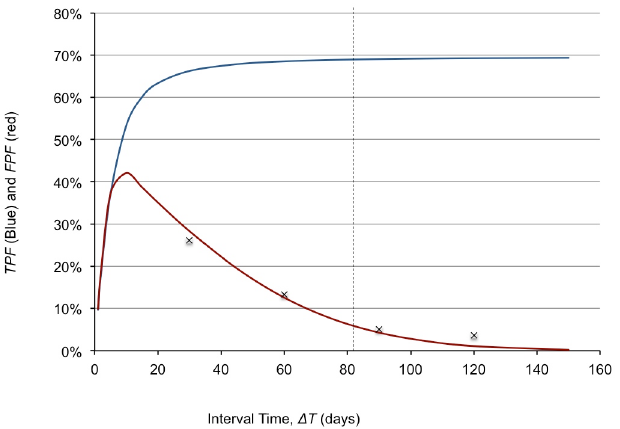
Fig 4. Calculation of True Positive Rate (TPR) and False Positive Rate (FPR). After 81 days (dashed line), the FPR is < 5%, with a TPR at a maximum value of 72% as determined by the k -distribution in 120 malignancies[9]. This relationship is independent of nodule volume due to the linearity of the standard error shown in Fig 3. Our calculated FPR agrees well with values computed from Gietema ’ s[15] “ coffee break ” study ( “ x ” labels shown on the graph) with simulated scan intervals of 30 – 180 days.